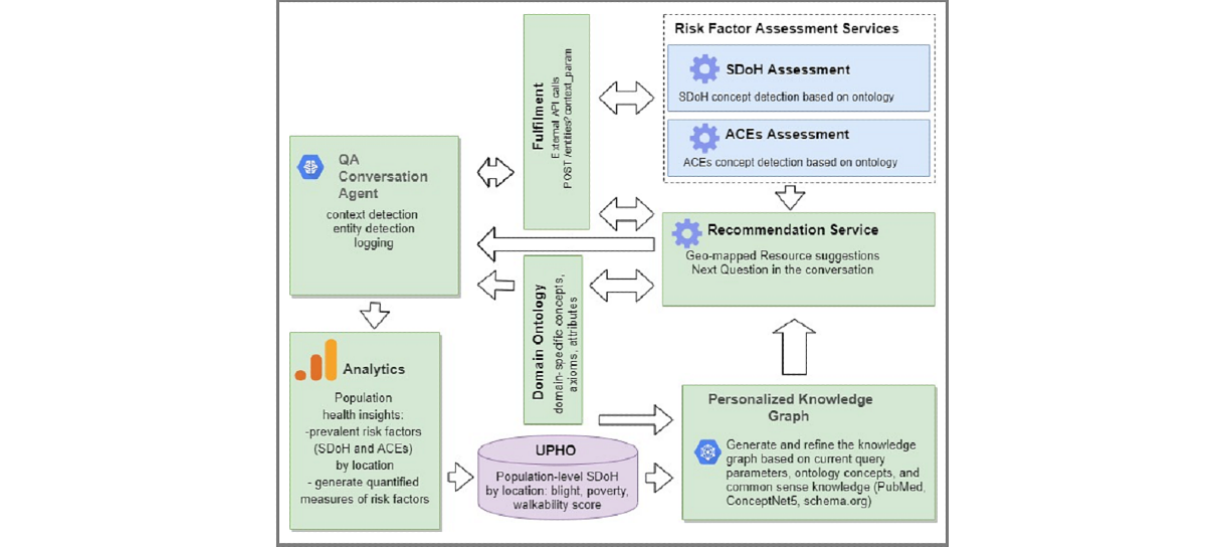
Figure 2. Architecture of the Semantic Platform for Adverse Childhood Experiences (SPACEs) that reflects the main components of the system. The blue components are the services that we implement for the mental health domain, and the green components reflect general components that can be generalized to any other domain. QA: question-answering; ACEs: adverse childhood experiences; SDoH: social determinants of